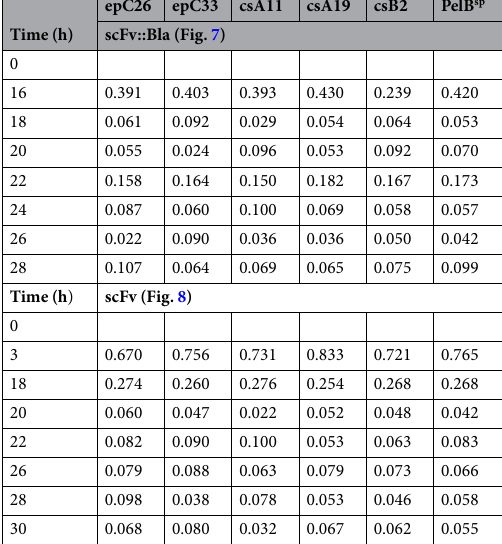
Table 2. Specific growth rates for fed-batch fermentation